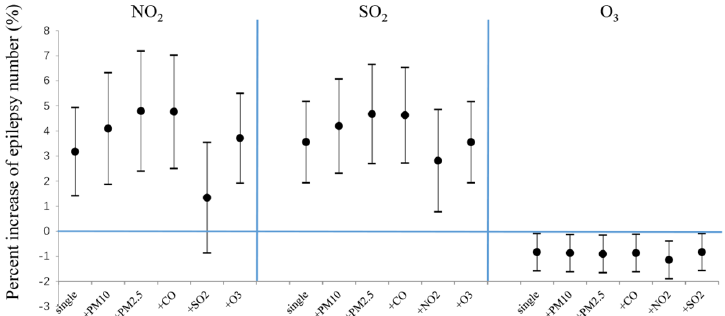
Fig 2. Percent increase in number of daily outpatient-visits for epilepsy associated with a 10- μ g/m 3 increase of air pollutants (NO 2 , SO 2 , and O 3 ) in two-pollutant models. Values are reported as means and 95% confidence